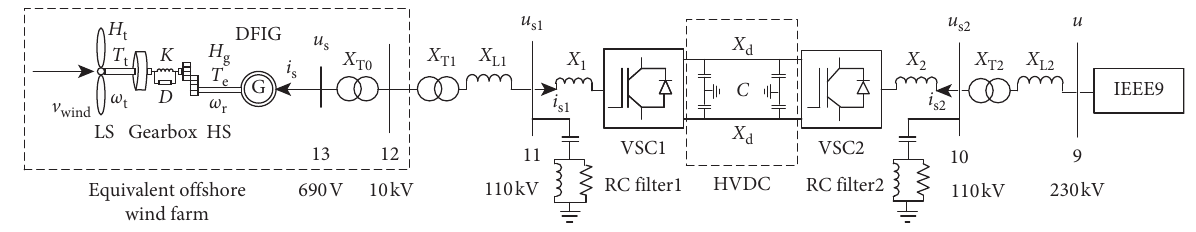
Figure 1: The topology of the whole